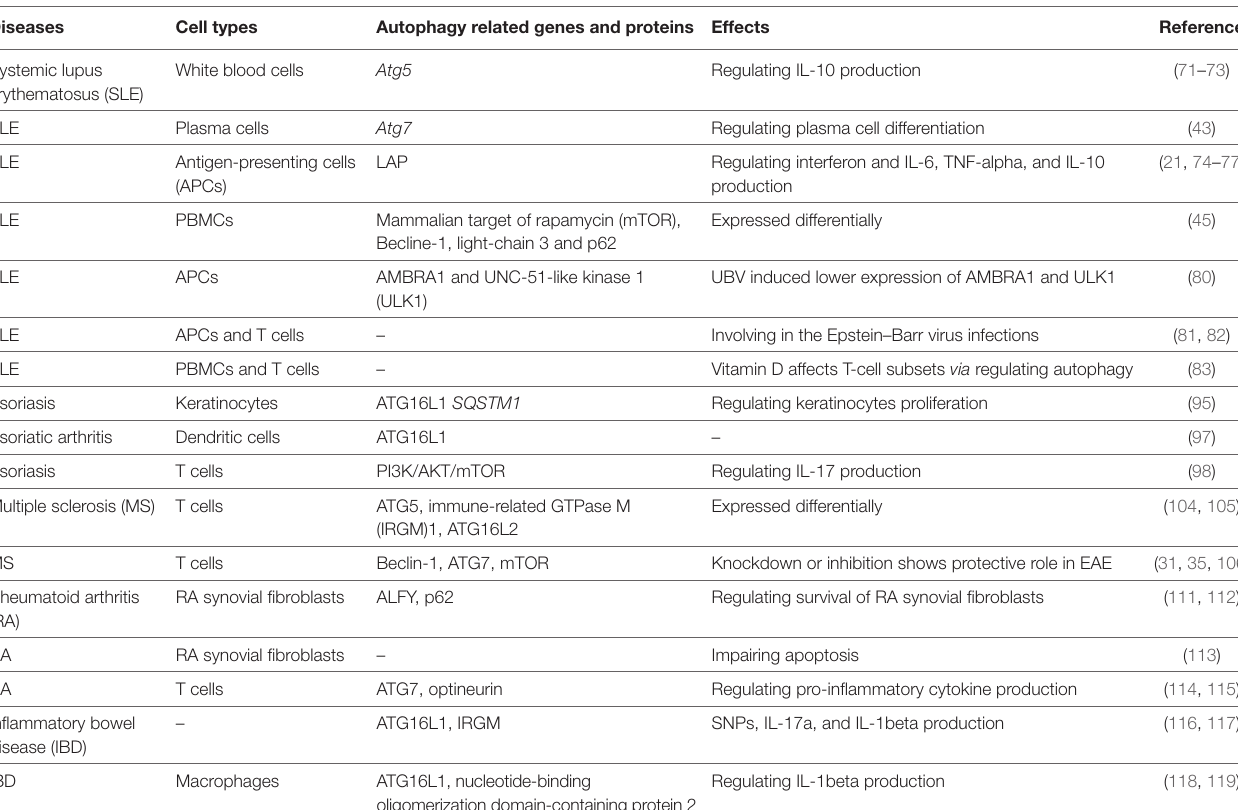
TABLe 1 | The regulation of autophagy in autoimmune